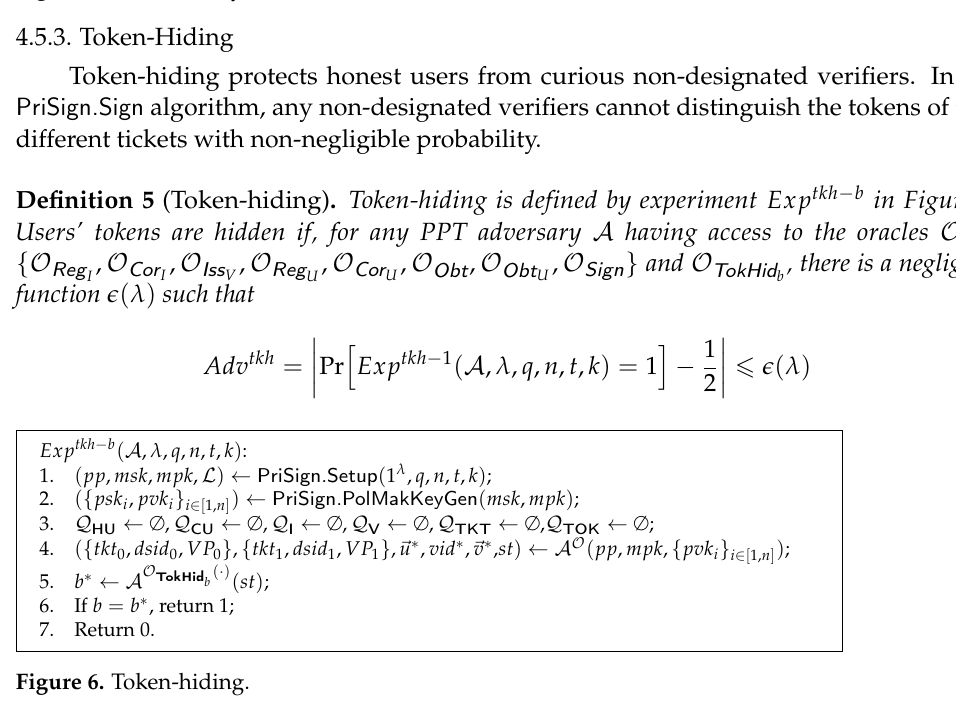
Figure 5. Unlinkability of tokens.